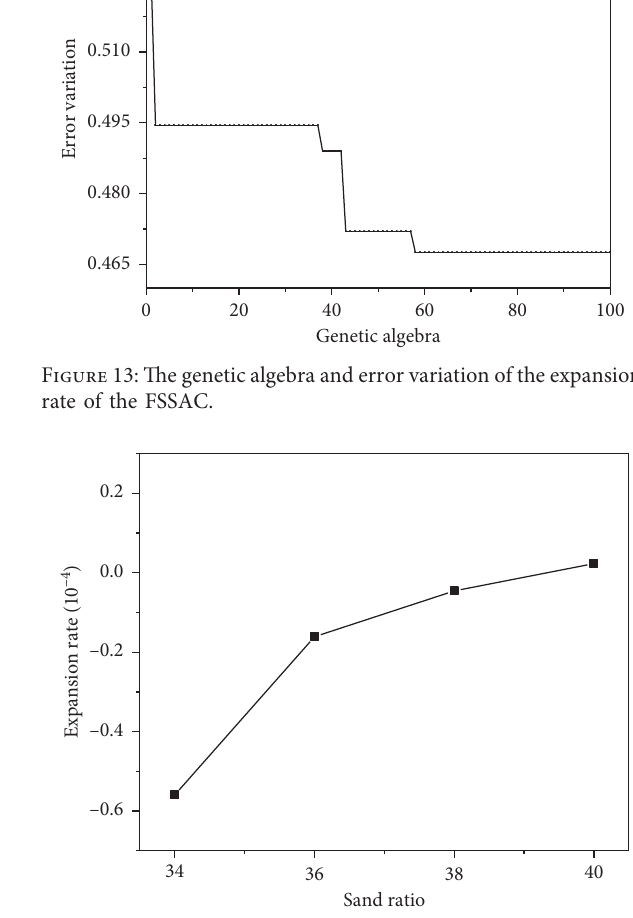
Figure 14: The impact of the sand ratio on the expansion rate of the